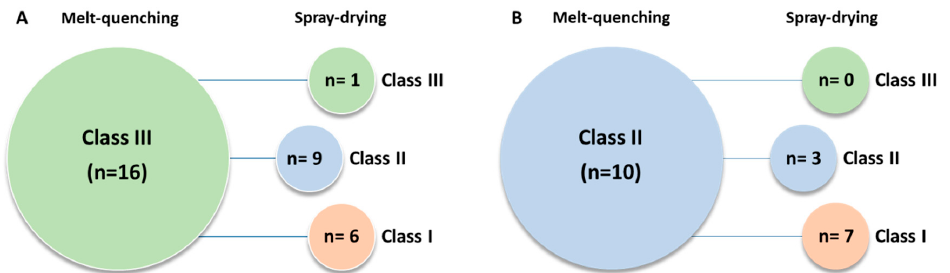
Figure 2. The number of compounds in glass-forming ability/glass stability ( a ) Class III and ( b ) Class II according to in situ DSC melt-quenching compared to glass-forming ability/glass stability classes according to spray-drying, respectively. Pink, blue, and green represent Classes I, II, and III, respectively.